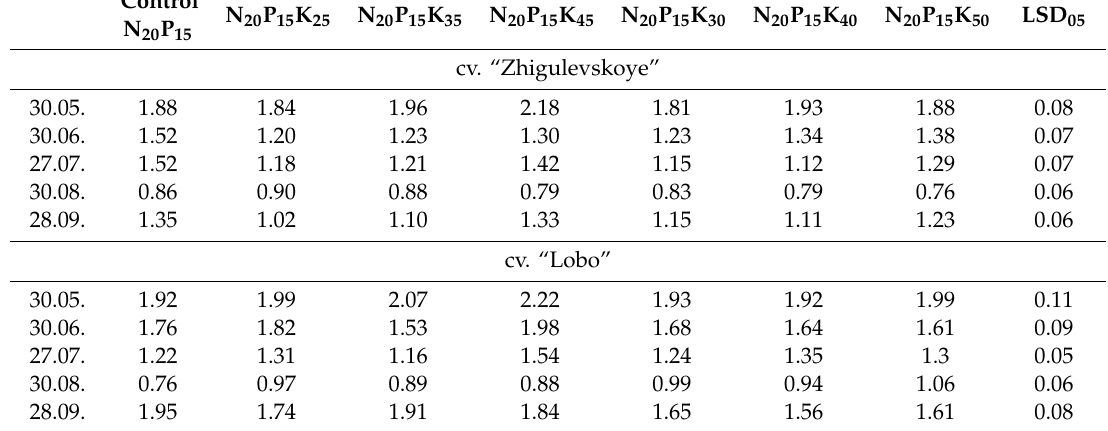
potassium fertilization rates and fertigation approaches in 2017, % d.m.